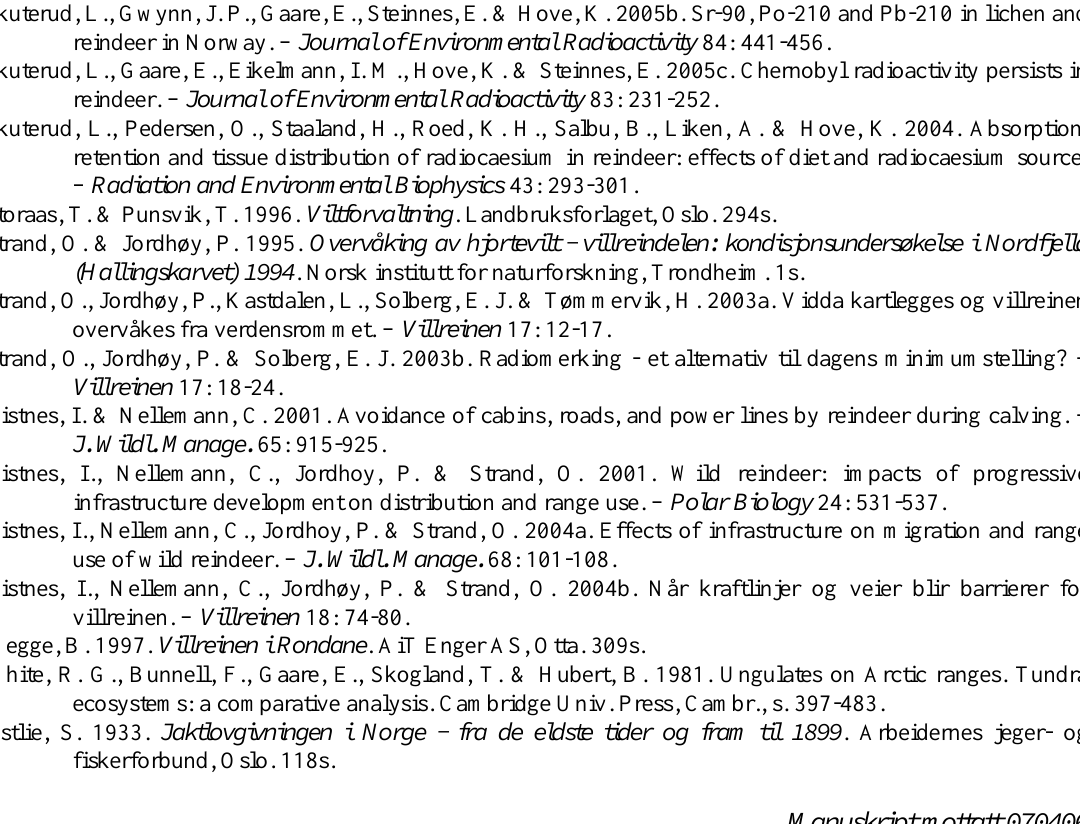
Figurtekst til kart over Sør-Norge / Legend for the map Forvaltningsmessig inndeling av de 23 villreinområdene i Norge (modifisert etter Andersen & Hustad, 2004) og oversikt over tamreinområdene i Sør-Norge (modifisert etter Reindriftsforvaltningen, 2006). Kartet er hentet fra Reimers & Colman (2006). Distribution in southern Norway of wild reindeer areas (Modified from Andersen & Hustad, 2004) and domesticated reindeer areas (Modified from Reindriftsforvaltningen, 2006). (Map from Reimers & Colman,